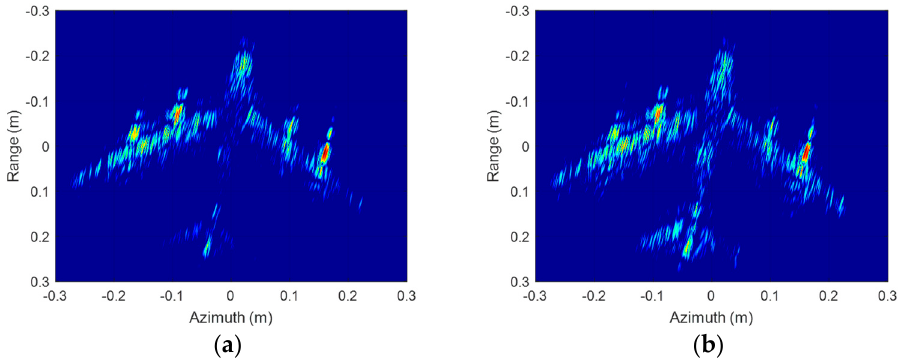
Figure 12. ISAR imaging results of A380 model with 20° rotation angle. ( a ) Antenna A; ( b ) Antenna B.